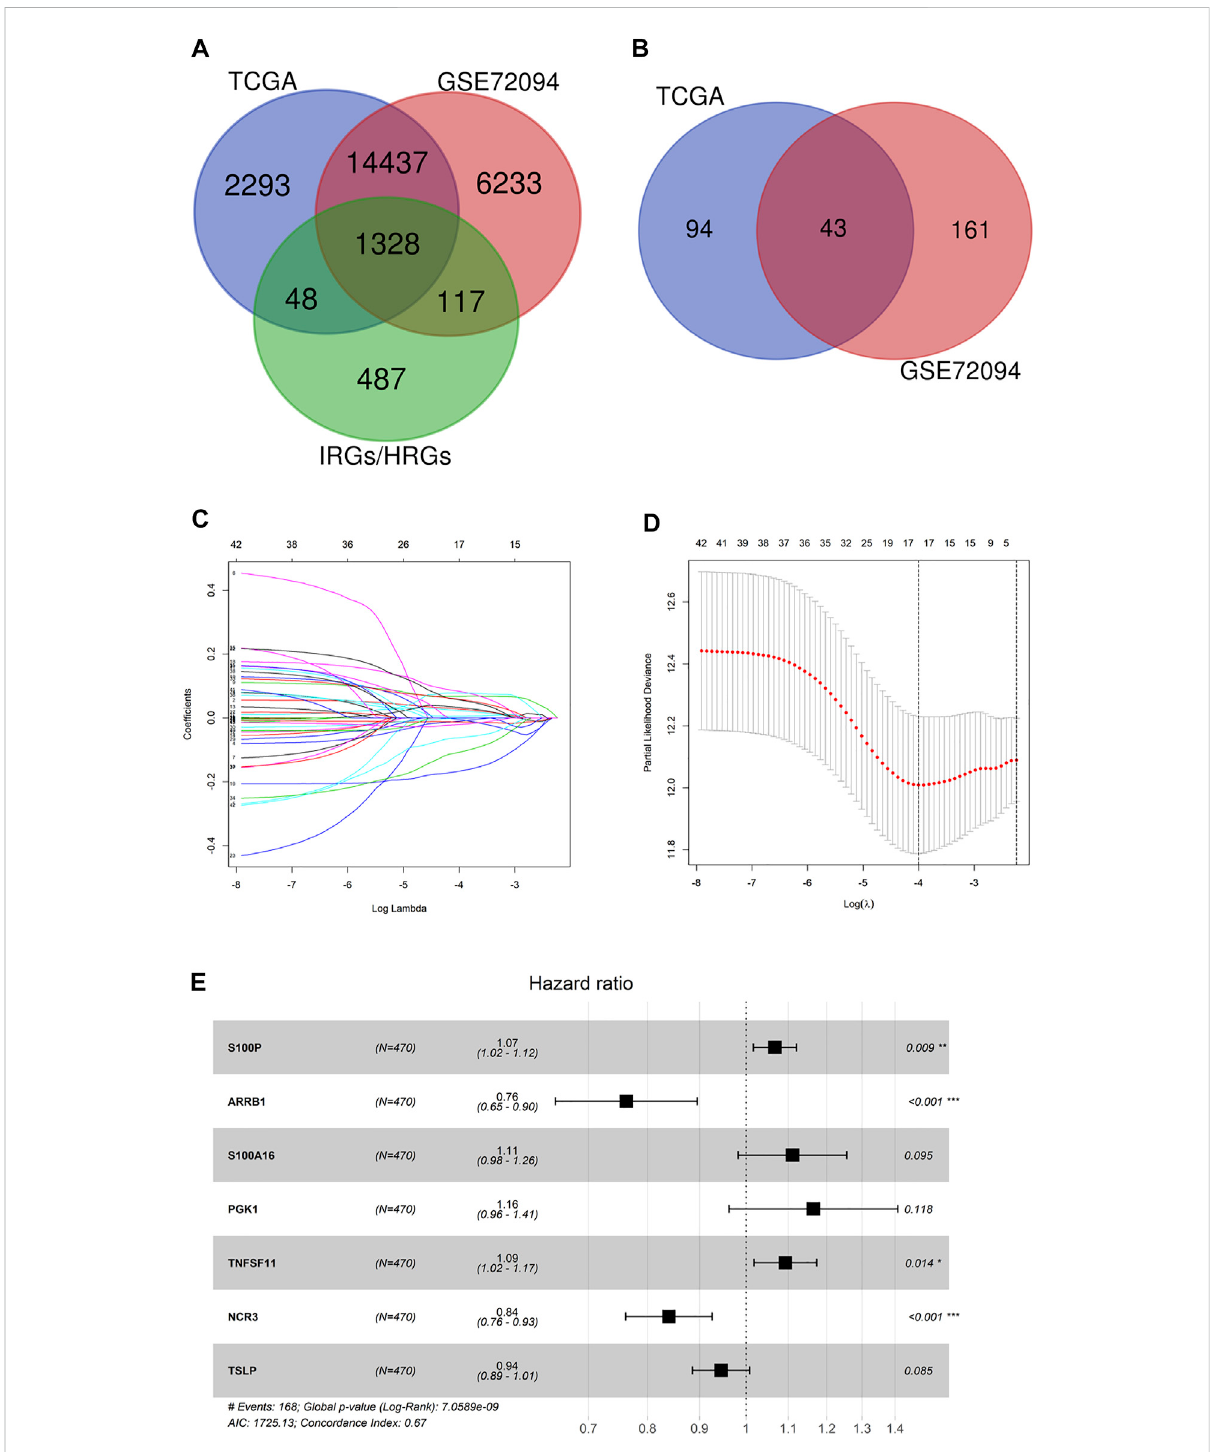
FIGURE 1 Identi fi cation of immune-hypoxia related prognostic genes in LUAD. (A) Venn diagram of immune-hypoxia-related genes in TCGA-LUAD, GSE72094 and IRGs/HRGs; (B) Venn diagram of OS-related genes in TCGA-LUAD and GSE72094; (C) Gene coef fi cient spectrum in LASSO Cox regression analysis of 43 OS-related genes in TCGA-LUAD cohort; (D) Selection of optimum penalty parameter ( λ ) in LASSO Cox regression model; (E) Forest plot of Cox regression analysis, * p < 0.05, ** p < 0.01, *** p <